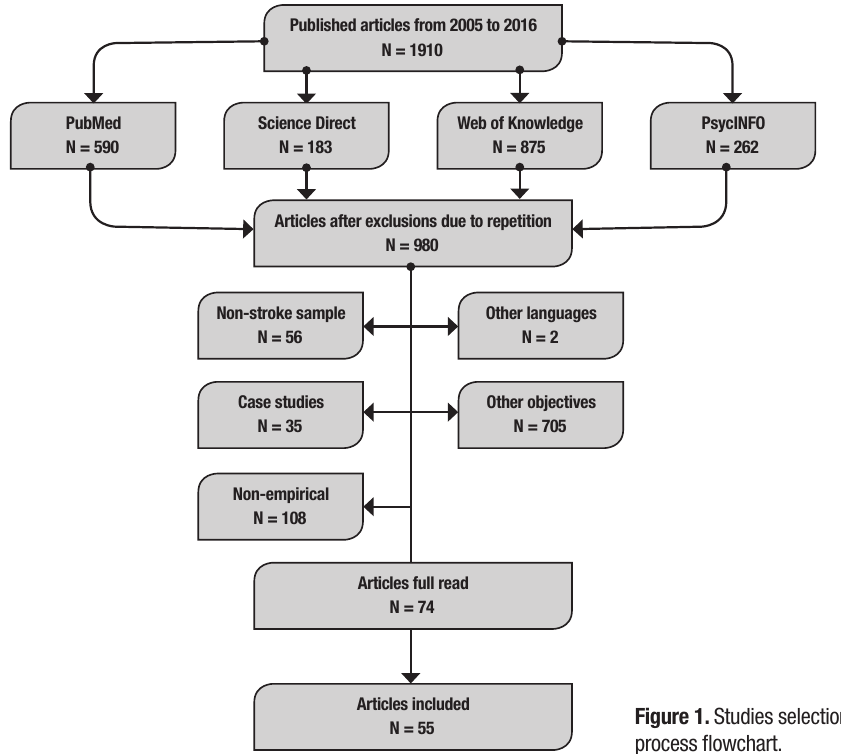
Figure 1. Studies selection process